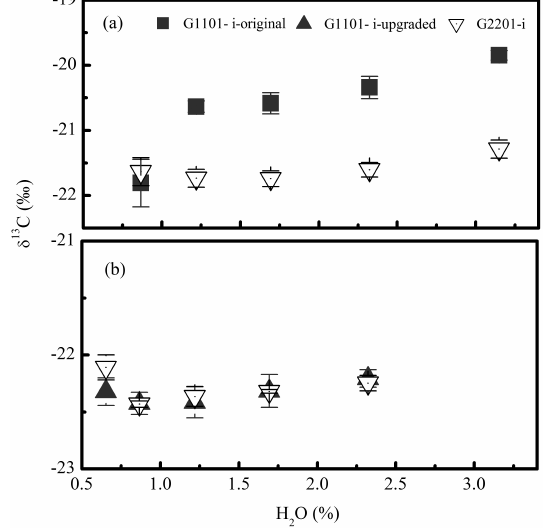
Figure 5. Sensitivity of the measured δ 13 C by G1101-i and G2201- i on water vapor mixing ratio. Panel (a) shows sensitivity mea- sured before G1101-i was upgraded (G1101-i-original and G2201-i) and (b) sensitivity measured after G1101-i was upgraded (G1101-i- upgraded and